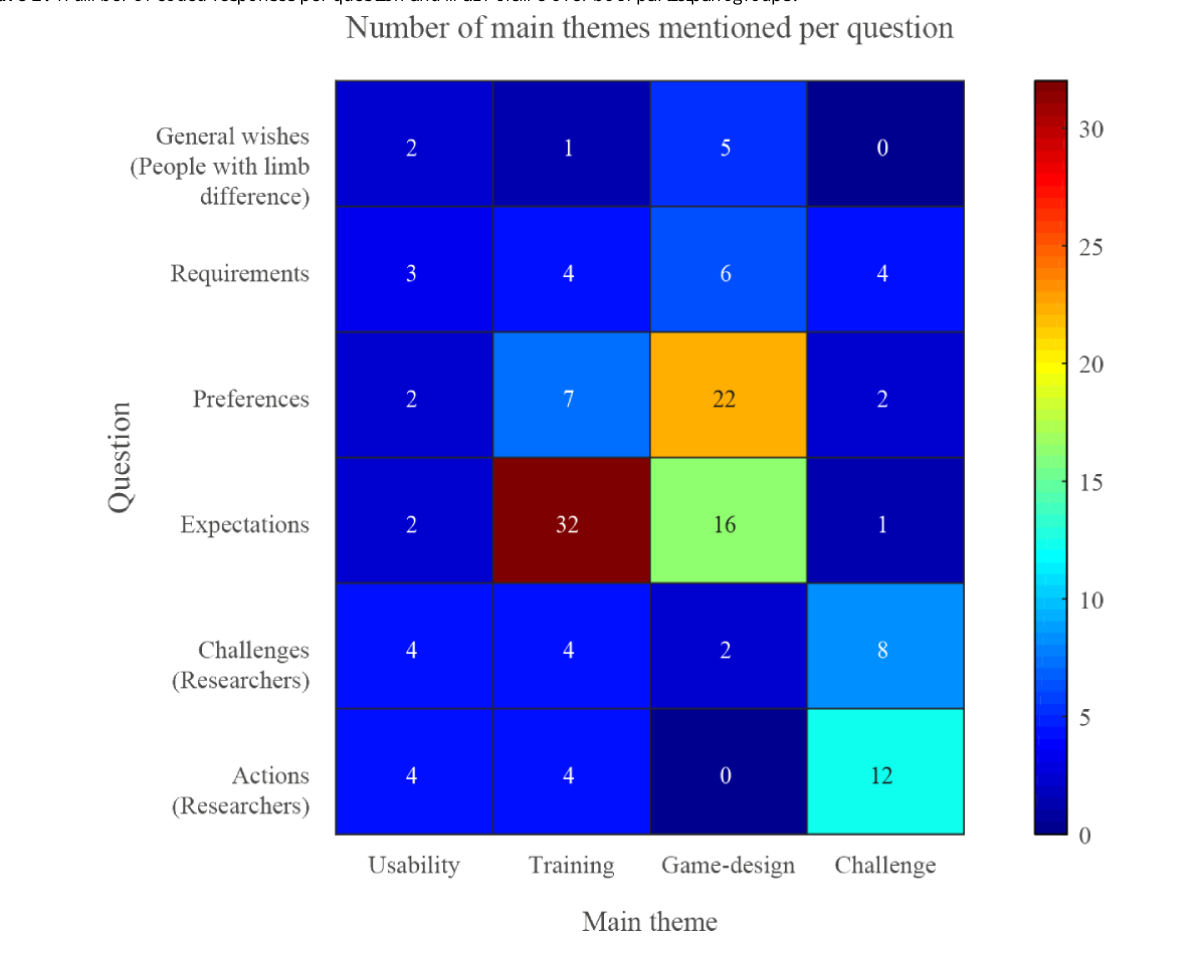
Figure 2. Number of coded responses per question and main theme over both participant